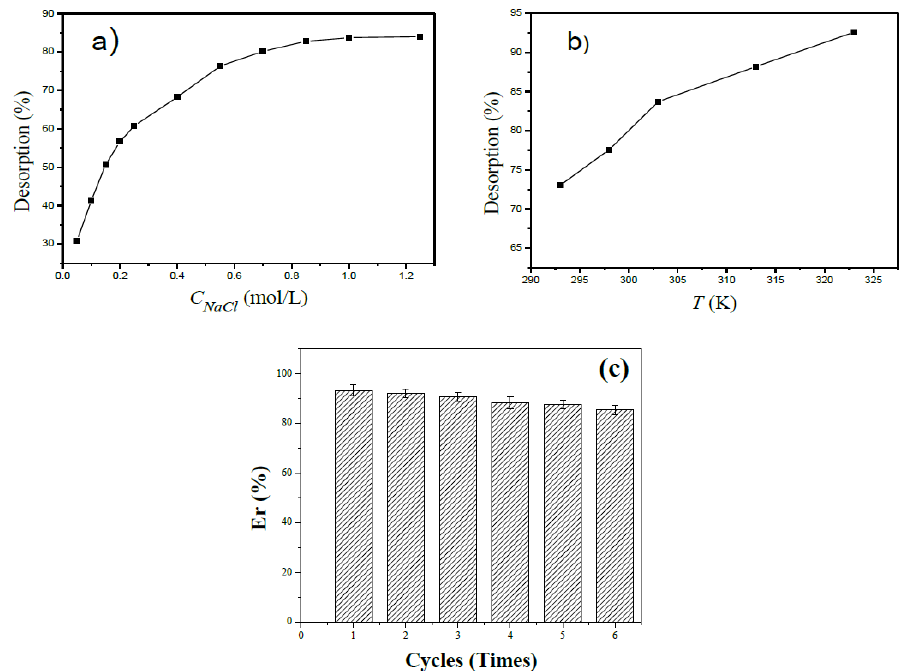
Figure 9. The influences of the NaCl solution concentration ( a ) and temperature ( b ) on desorption and the regeneration efficiencies of the prepared hydrogel ( c